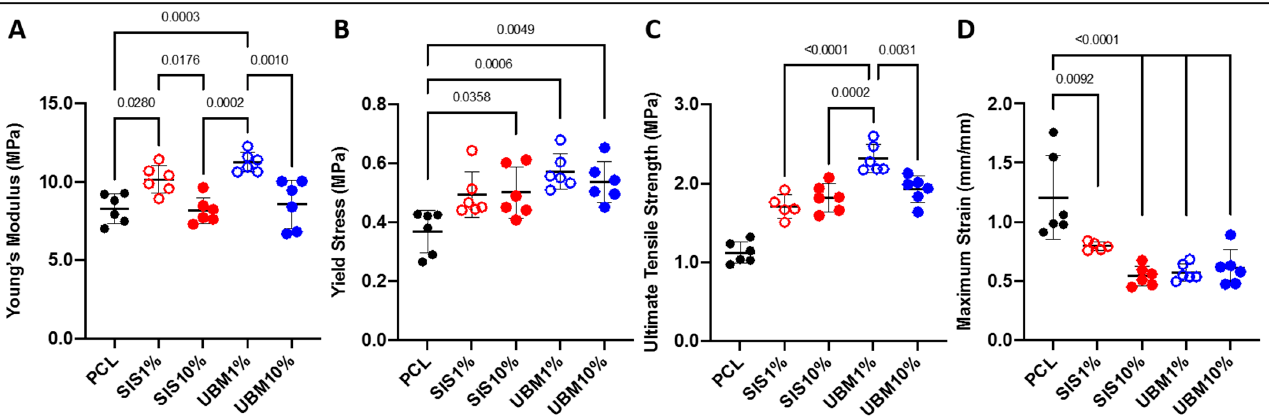
Figure 6. Tensile testing data for scaffolds of electrospun poly( ε -caprolactone) (PCL) and with the addition of 1% or 10% decellularised tissue powder (small intestinal submucosa (SIS) and urinary bladder matrix (UBM)): ( A ) Young’s modulus, ( B ) yield stress, ( C ) ultimate tensile strength and ( D ) maximum strain at break. One-way ANOVA with Tukey’s multiple comparisons ( n = 6), significance for p < 0.05. Statistical differences shown by p values.